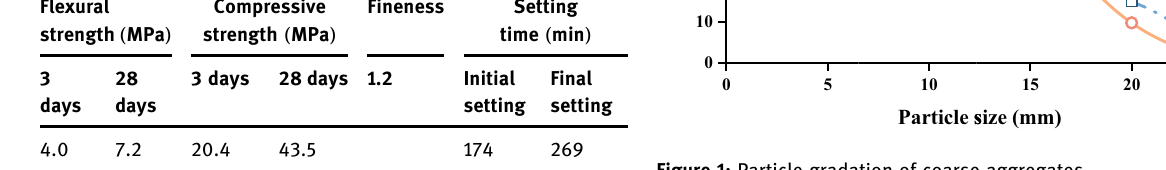
Figure 1: Particle gradation of coarse